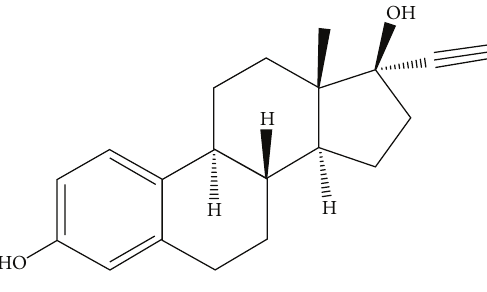
Figure 1: Chemical structure of